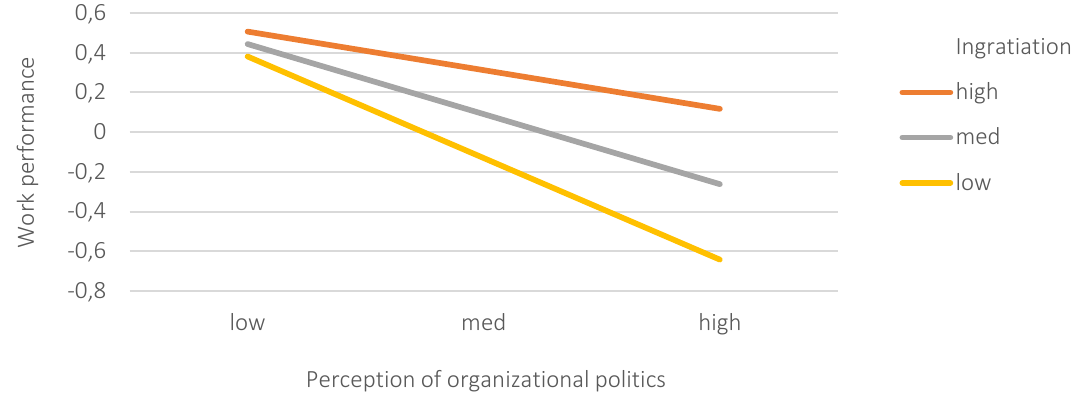
Figure 2. Interactive effect of perception of organizational politics and ingratiation on work